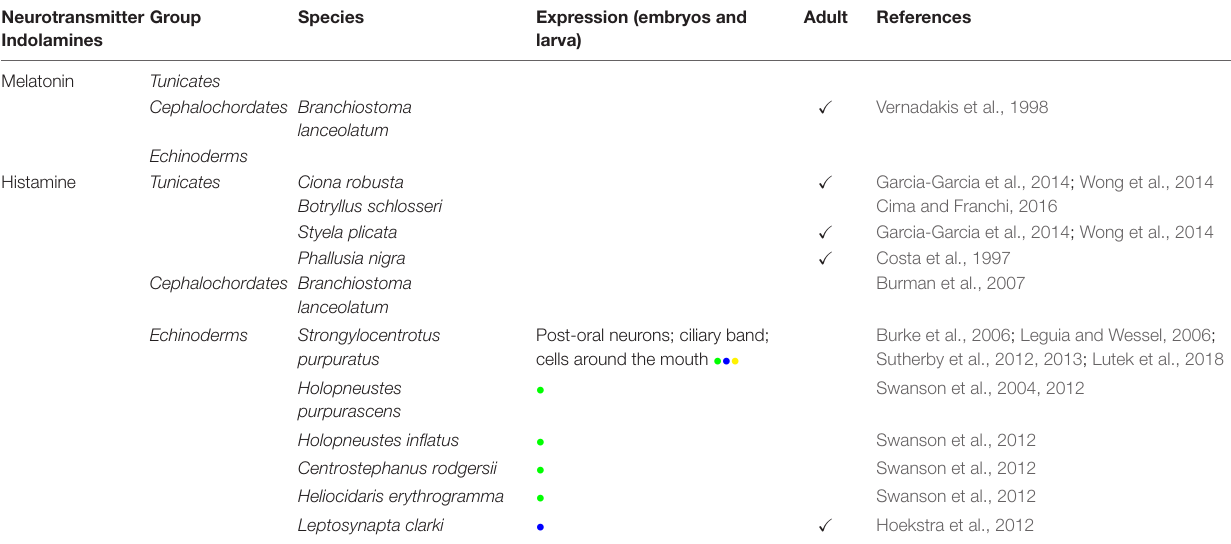
Color code: • Neurotransmitters (whole mount in situ hybridization or immunofluorescence). • Metabolizing Enzymes or receptors (whole mount in situ hybridization or immunofluorescence). • Enhancer activity. • Other methods.